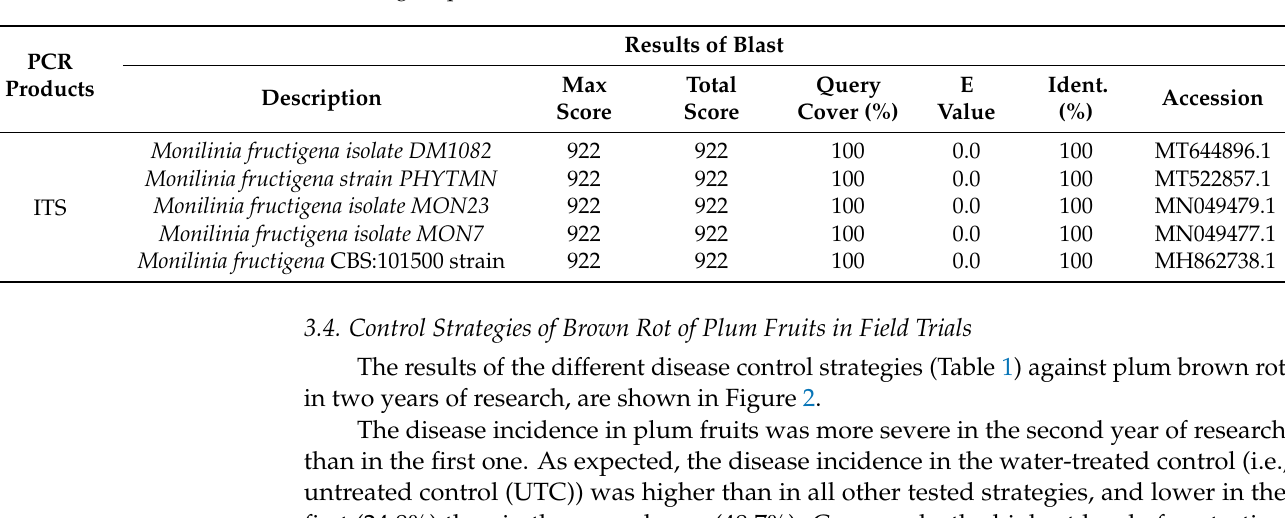
Table 2. Main results of alignments between the sequences of ITS region of isolated pathogen and other fungi sequences in